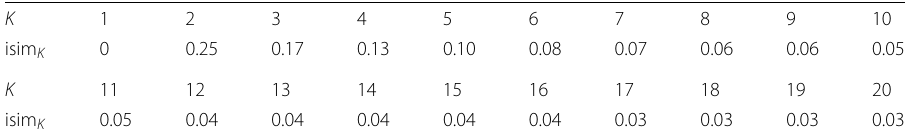
Table 5 Real: intersection similarity between the top K = 1, 2, . . . , 20 ranked nodes in Q [ M ] 1 and (cid:12) Q [ M ] 1